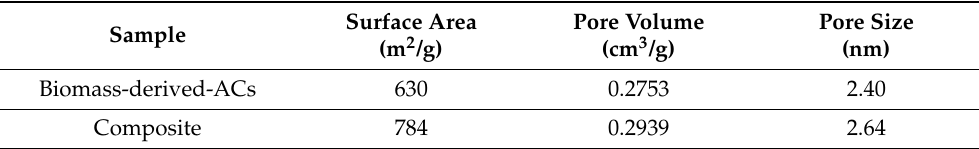
Table 3. Surface area, pore size, and volume of the biomass-derived-ACs and the Fe 3 O 4 -carbon-based composite as measured by BET analysis.